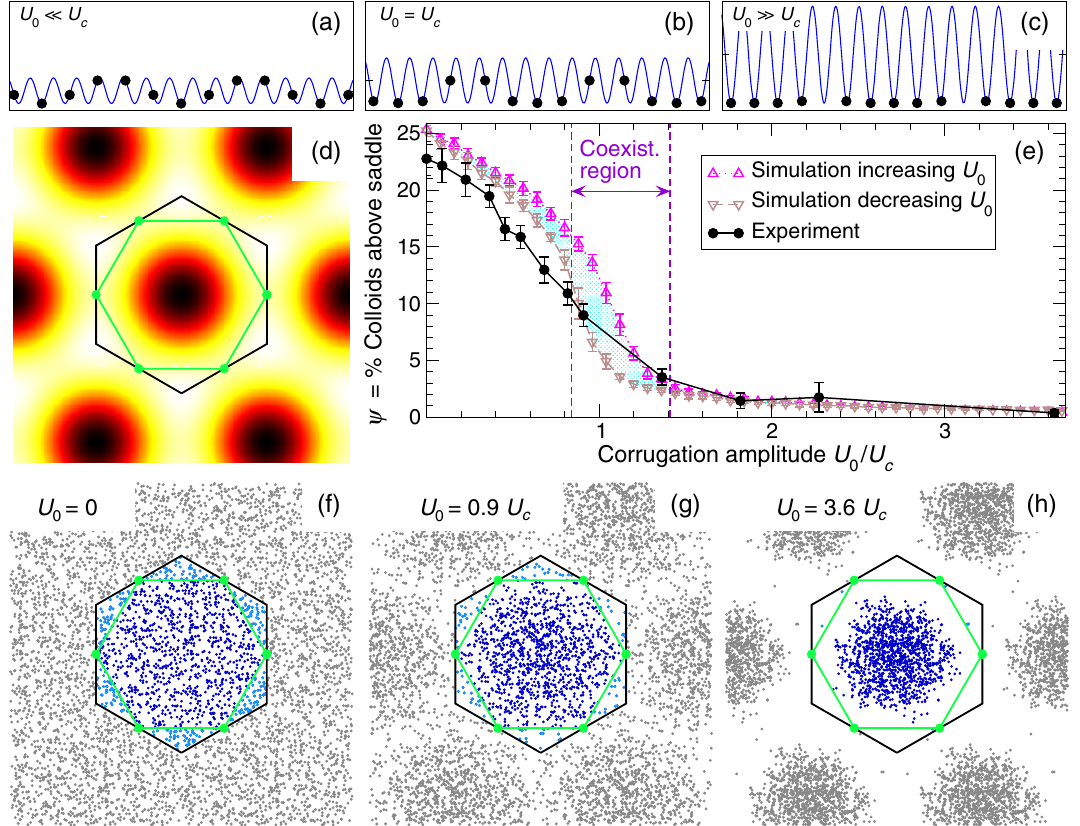
FIG. 3. Local energetics across the Aubry transition. For increasing U 0 , a substrate-mismatched 1D FK chain evolves from a configuration in which (a) minima and maxima regions are populated (superlubric), (b) no particles can be found sitting close to any maximum (pinning threshold), and (c) only regions around the minima are occupied (strongly pinned). (d) The 2D corrugation-potential profile (dark = light ¼ low = high energy); the repulsive regions correspond to the area between the green (saddle-energy contour level) and the black (Wigner-Seitz cell) hexagons. (e) For the 2D colloid crystal, we show the fraction Ψ of colloids in the repulsive regions as a function of U 0 , illustrating the statistical crossover from superlubric to pinned. (f) – (h) Experimental particle positions folded within the Wigner-Seitz cell of the corrugation